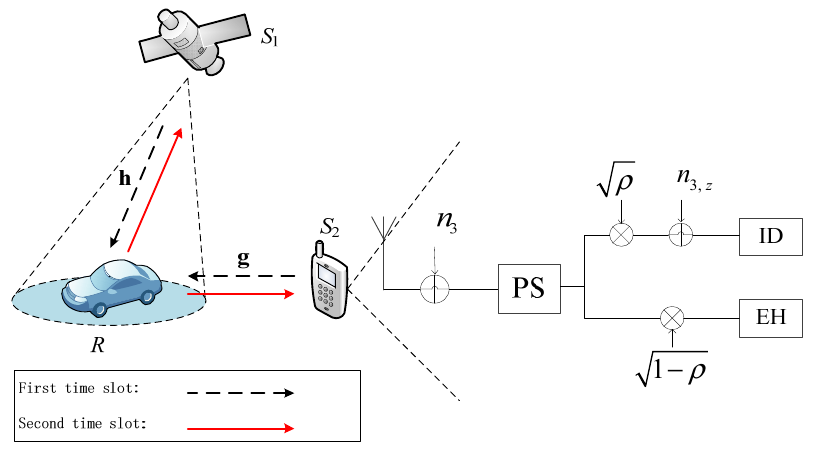
Figure 1. Illustration of the system model.